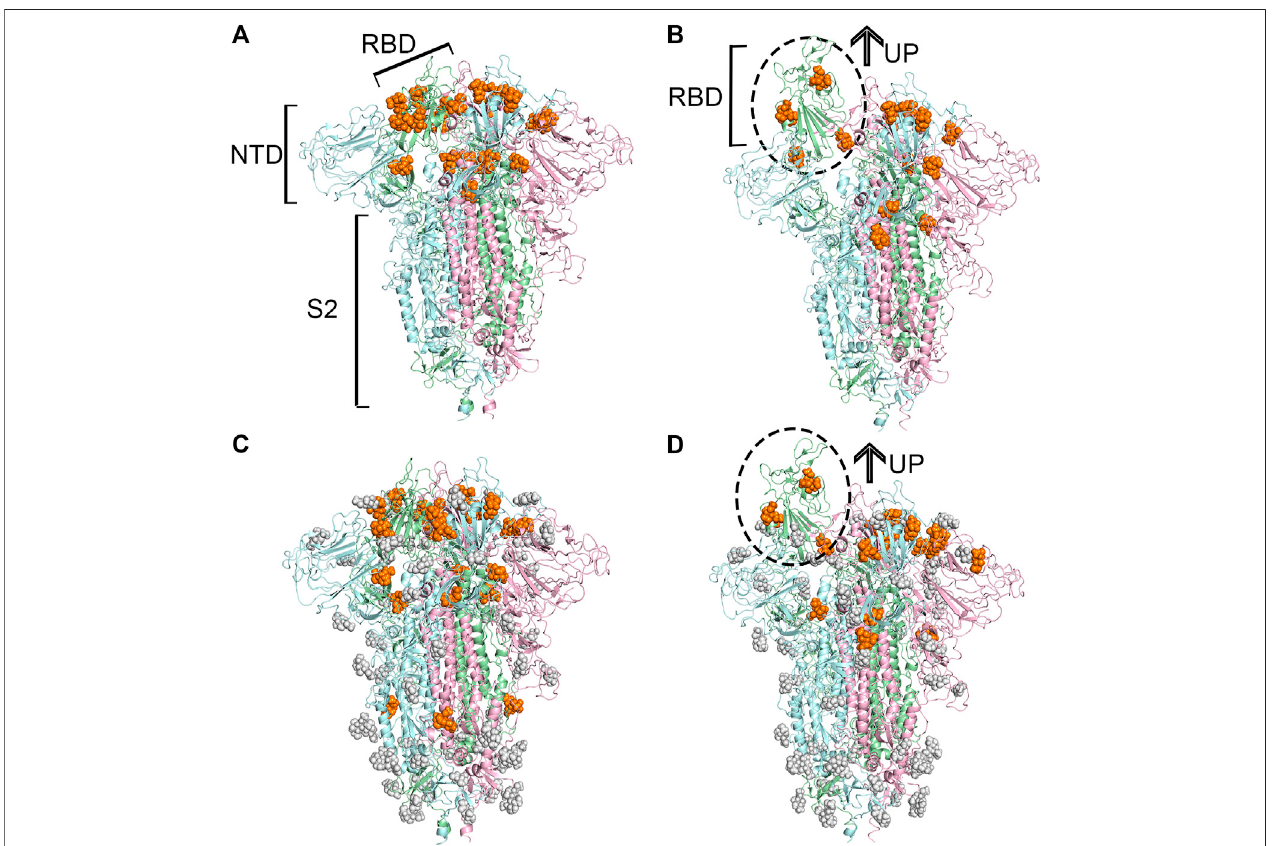
FIGURE1 | Predicted potential bindings ofsialic acids on the surface ofthe spike protein. Potentialligandable binding sites were identi fi ed on the four constructed models of the trimeric spike protein by using FTMap (Ngan et al., 2012) and SiteMap (Halgren, 2009). The different colors of the cartoon models in each fi gure represent different chains of the protein: chain A is shown in pale-green, chain B is in pale-blue, and chain C is in light-pink. The protein structures which contain gray sphere balls represent glycosylated state S trimer (the gray sphere models are the glycosylation), and the orange balls represent sialic acid molecules. (A) 21 and (B) 15 sialic acidmoleculeswereobservedtobindtothedifferentplacesofthesurfaceofunglycosylatedspikeproteinin “ down ” and “ up ” conformationalstates,respectively, (C) 23 potential sites for sialic acid binding were identi fi ed on the surface of glycosylated spike protein in “ down ” conformational state, and 17 were found (D) in the “ up ” conformational